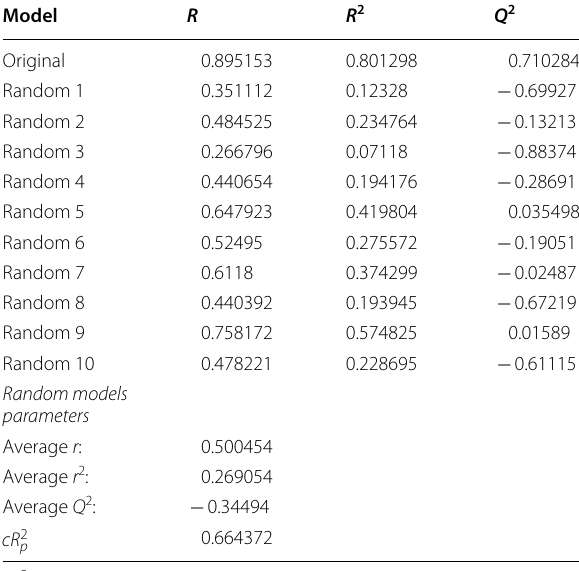
cR 2 p Y -randomization coefficient, R correlation coefficient for Y -randomization R 2 -correlation coefficient, Q 2 -cross-validated R 2